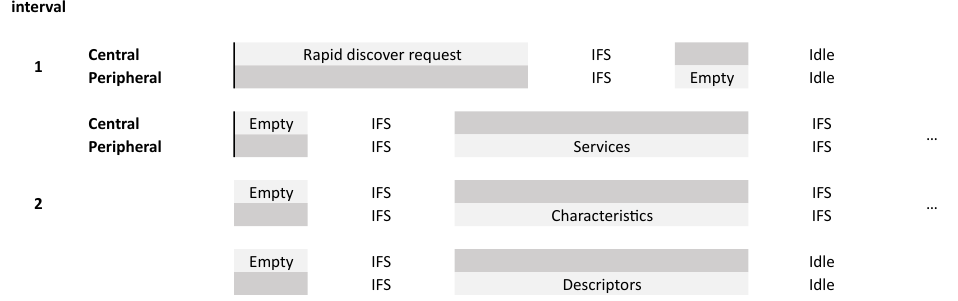
Figure 14. Rapid service discovery protocol.